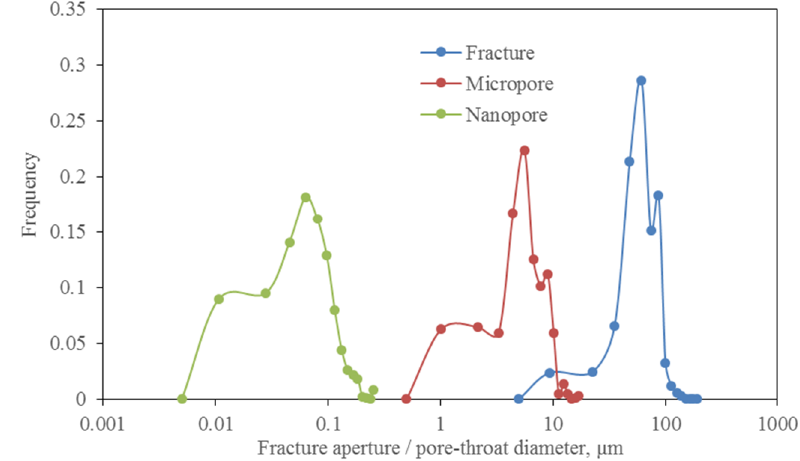
Figure 6. Fracture aperture/pore-throat diameter distribution.